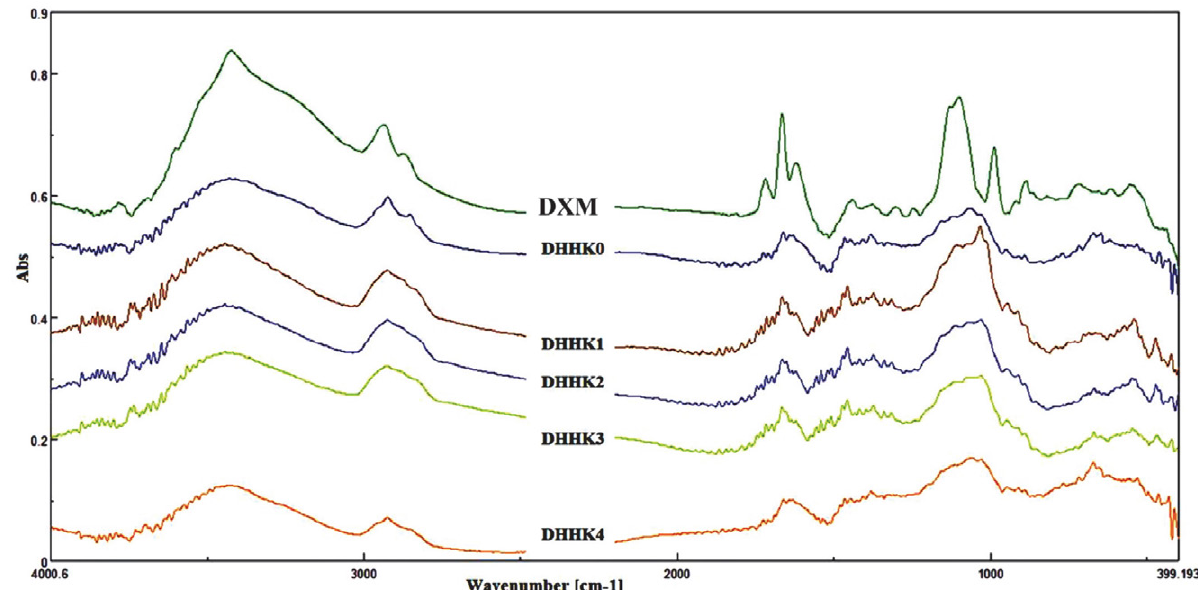
Figure 1. FTIR spectra of pure DXM and of the prepared film formulations (DH H K 0 , DH H K 1 , DH H K 2 , DH H K 3 , and DH H K 4